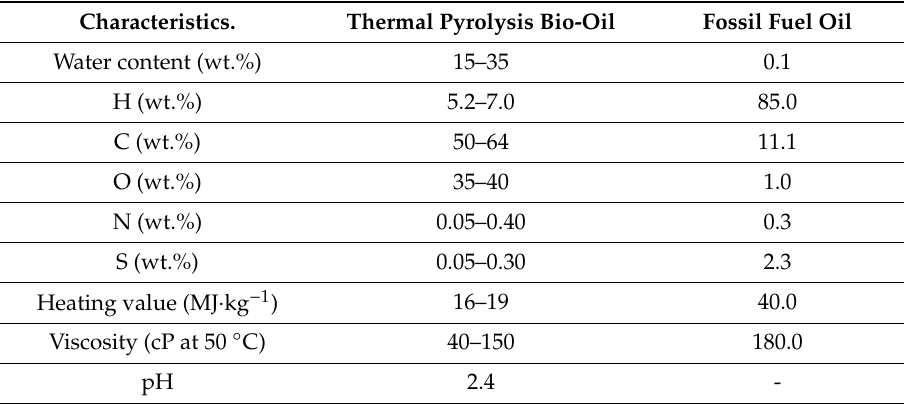
Table 2. Comparison of thermal pyrolysis bio-oil and fuel